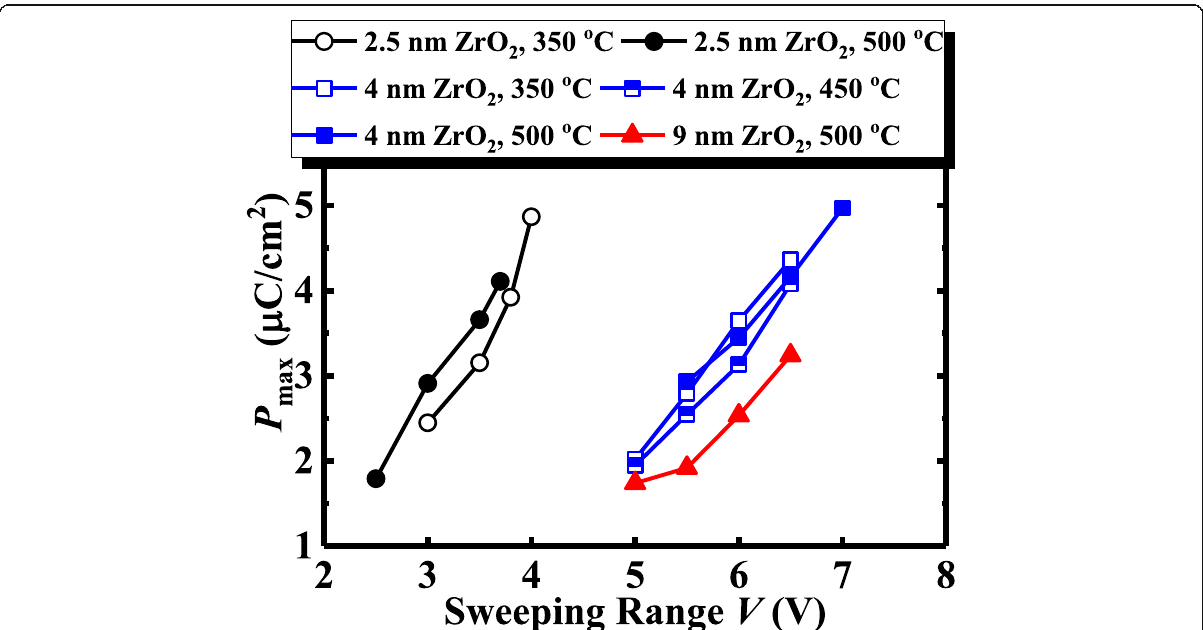
Fig. 3 Comparison of P max as a function of V range for the TaN/ZrO 2 /Ge capacitors with different ZrO 2 thicknesses and various annealing temperatures